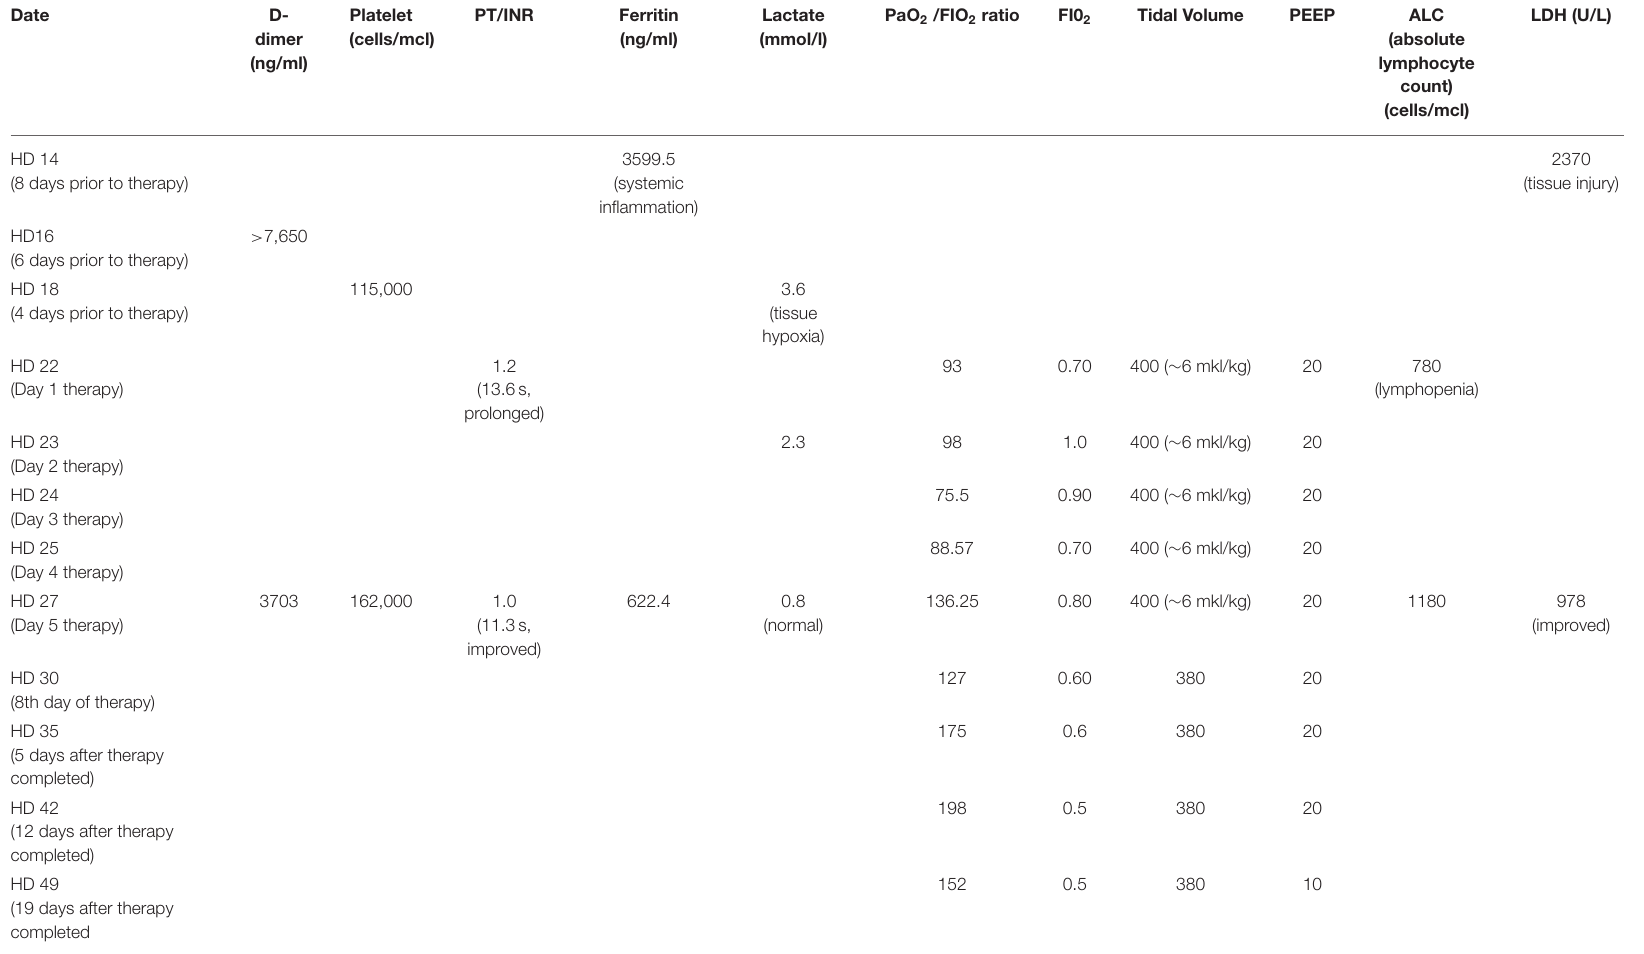
TABLE 1 | Laboratory values over time in emergency use case